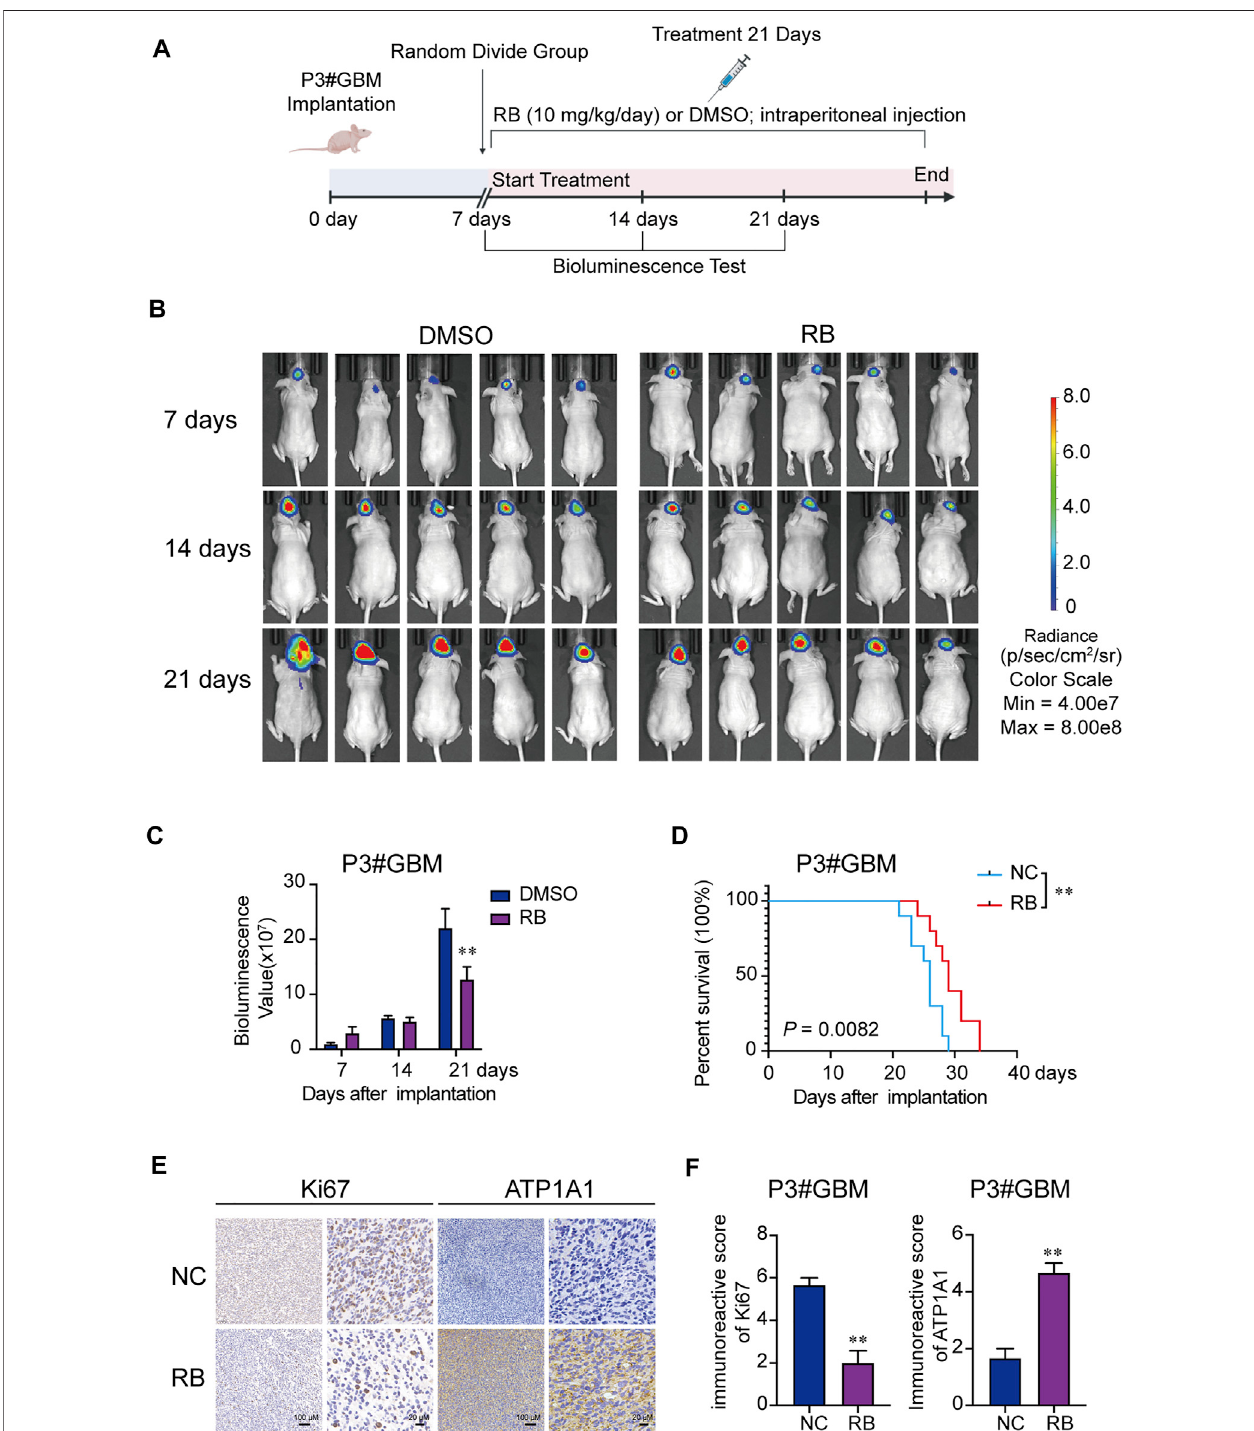
FIGURE 6 | RB exerts antitumor ef fi cacy in vivo . (A) Scheme of tumor inoculation and systemic injection. (B) P3#GBM-luciferase cells were orthotopically inoculatedintoBALB/cnudemice.PerkinElmerIVISSpectrummonitored tumorgrowth bydetecting bioluminescence. (C) Bioluminescencevaluesonthe7 th ,14 th ,and 21 st daysafterimplantation. (D) Kaplan – Meieranalysiswasperformedonthemediansurvivalofthetumor-bearingmice,andlog-rankanalysiswasusedtomeasurethe statistical signi fi cance of thedifferences. (E) ImagesofIHC stainingfor ATP1A1 and Ki-67 insections from brains oforthotopic P3#GBMtumor-bearing nude mice treatedwithDMSOorRB.Scalebars,100and20 μ m. (F) ImmunoreactivescoresofKi-67andATP1A1insectionsfromthebrainsoforthotopicP3#GBMtumor-bearing nude mice treated with DMSO or RB in (E) . Three independent experiments were performed with data shown as the mean ± SEM by two-way ANOVA (C) or unpaired Student ’ s t test (F) . Survival differences between groups were assessed by the log-rank test (D). * p < 0.05; ** p < 0.01 and *** p < 0.001.